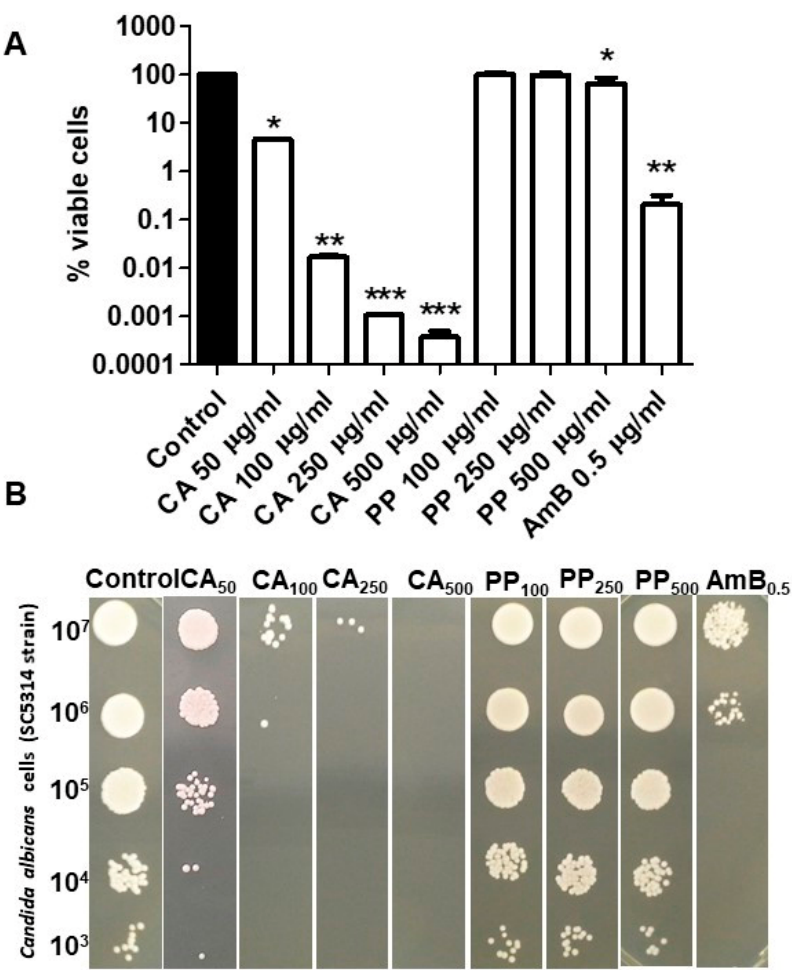
Figure 1. Fungicidal effect caused by the addition of CA or propolis (PP) on the standard strain SC5314 of C. albicans . Exponential cells were aliquoted and treated for 1 h at 37 °C with the indicated concentrations of CA and PP. Samples for each treatment and a control (black bar) were spread on YPD plates and the viability was determined by CFU counting ( A ). The macroscopic colonial growth in the different conditions was also recorded in solid media. 10 7 cells/mL were diluted in YPD and 10-fold dilutions thereof, were spotted in 5 µL onto YPD agar. The plates were further incubated at 37 °C and scored after 24 h ( B ). Amphotericin B (AmB) was included as a positive antifungal control. The data shown are representative of three independent experiments. Statistically significant differences (* = P < 0.05; ** = P < 0.01; ***, P = 0.001) with respect to an untreated control according to Mann–Whitney U test.